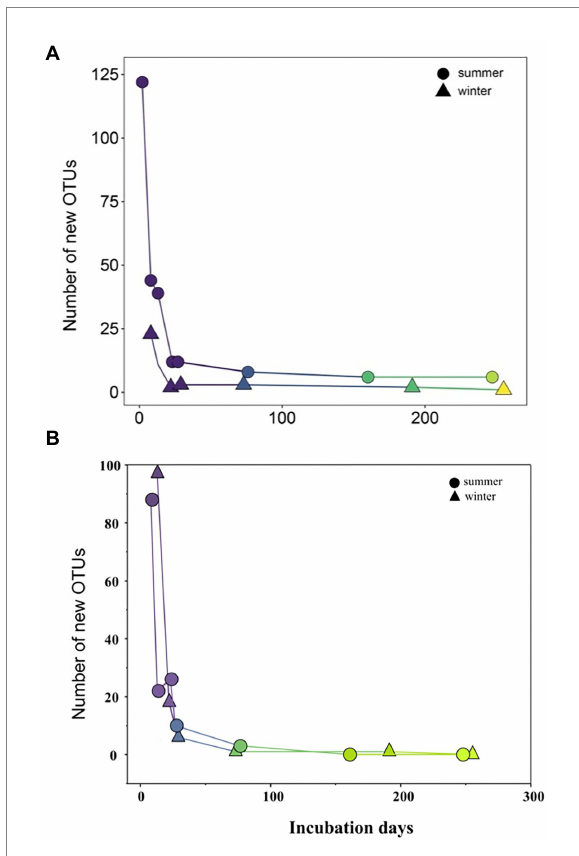
FIGURE 5 Newly occurred (A) and lost (B) microbial ASVs along summer and winter